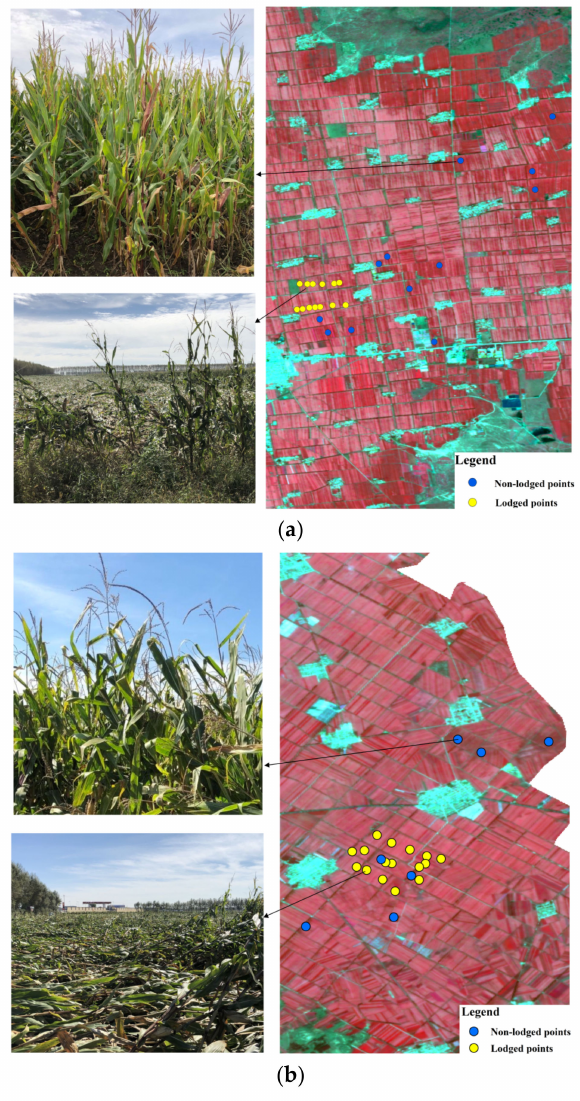
Figure 3. Distribution of sample points overlaid on Gaofen1 images in ( a ) Zhaodong City and ( b ) Ningjiang